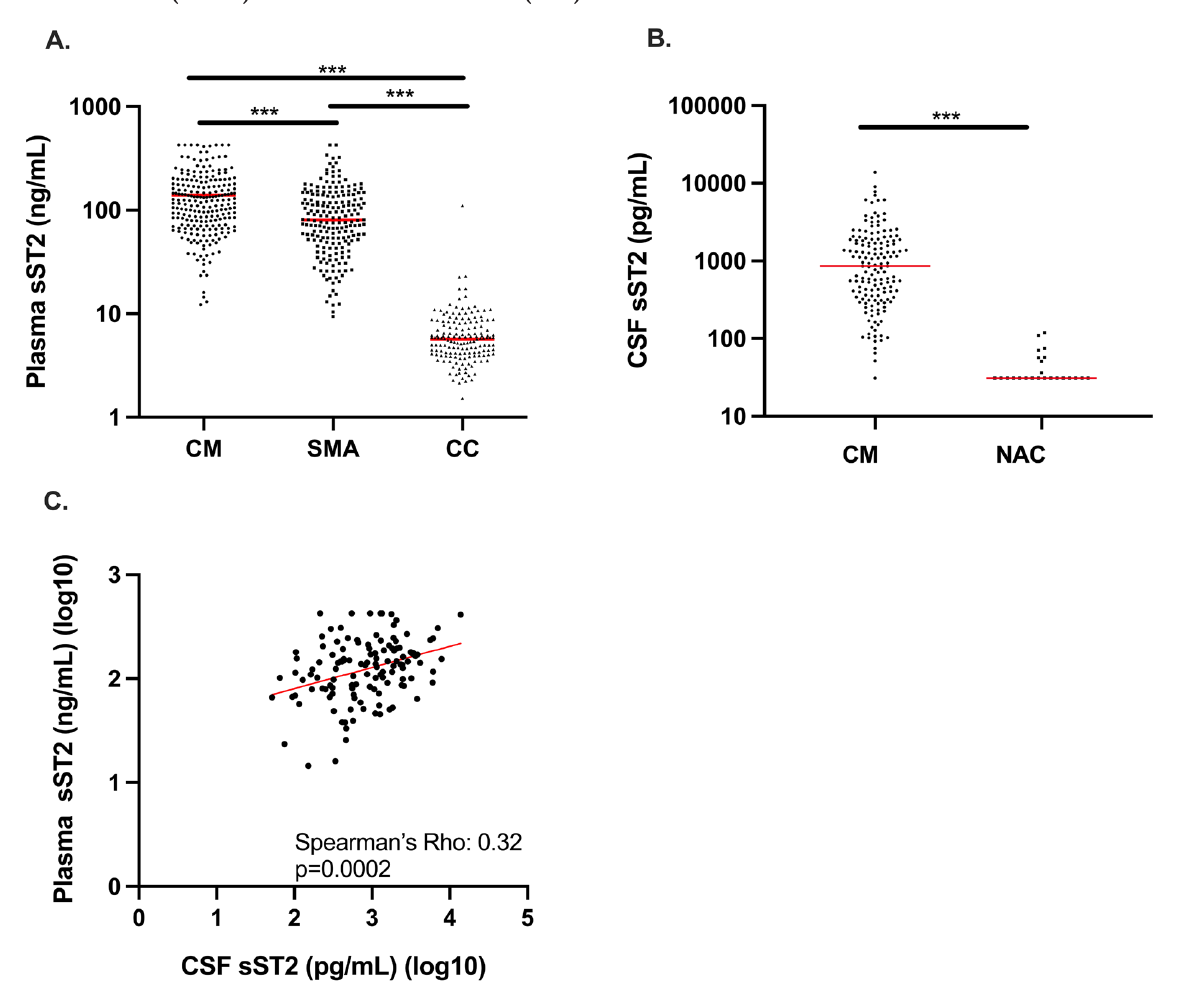
Figure 2. Plasma and CSF levels of sST2 in Ugandan children with cerebral malaria, children with severe malarial anemia, and community control children. (A) Levels of sST2 were elevated in children with CM (n=224) or SMA (n=193) compared with asymptomatic community control children (CC, n=156). (B) Concentration of sST2 in the CSF of children with CM (n=153) was higher compared to that of healthy North American Control (NAC) children (n=24). (A,B) Wilcoxon Rank Sum Test was used to compare each group. *** P <0.0001. (Circles) Plasma sST2 concentration in individual children, (horizonal bar) median sST2 concentration for each group. (C) Plasma and CSF levels of sST2 were correlated using Spearman’s correlation (rho=0.32, P =0.0002, n=128). (Red line) Line of best fit based on linear regression